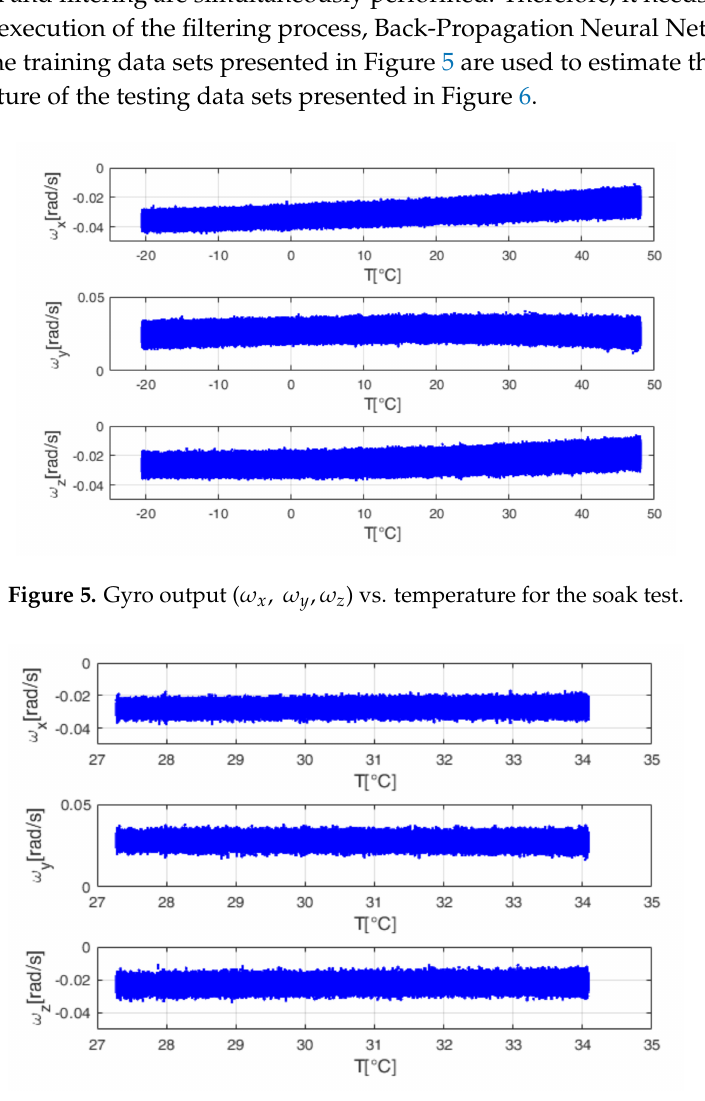
Figure 6. Gyro output ( ω x , ω y , ω z ) vs. temperature for the ramp